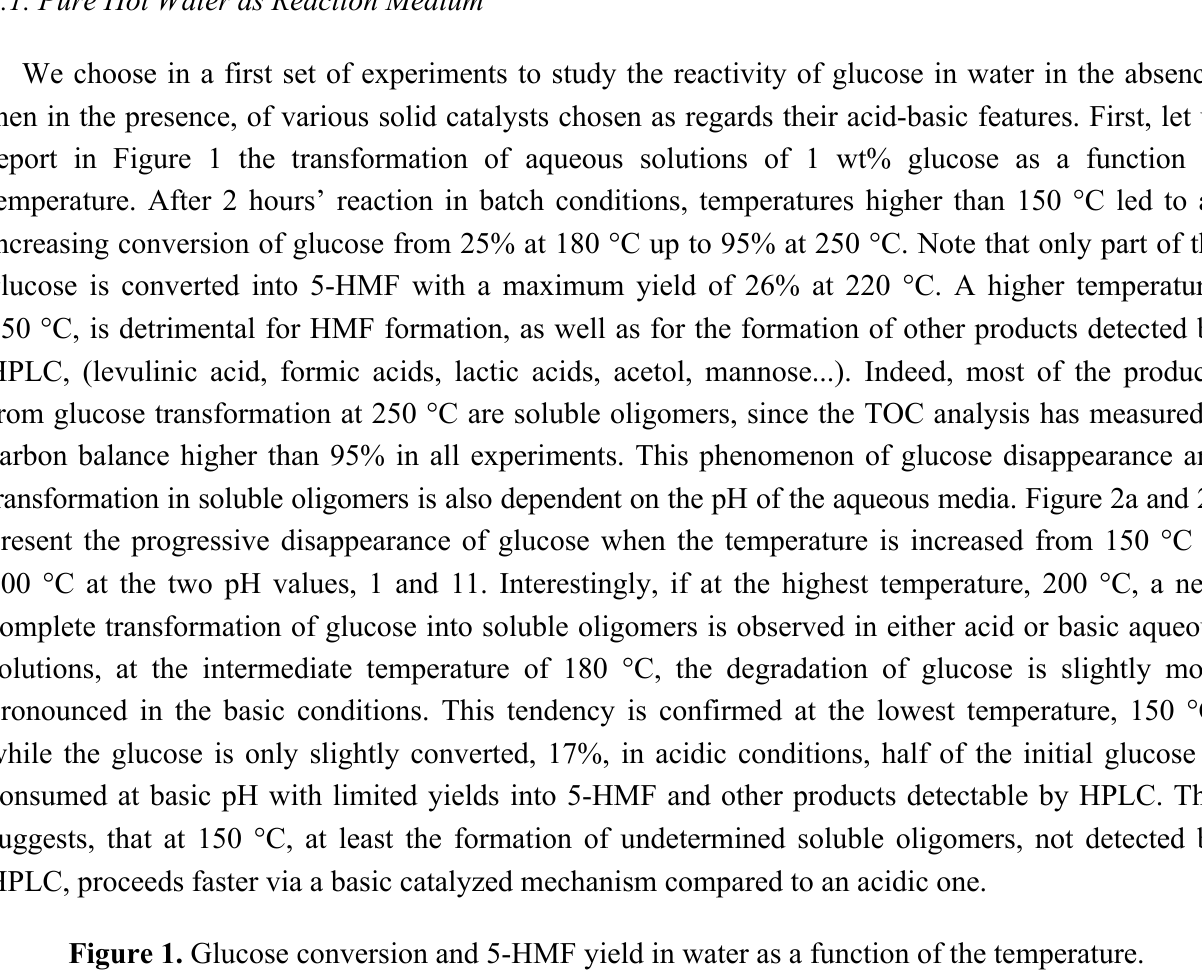
Figure 1. Glucose conversion and 5-HMF yield in water as a function of the temperature.